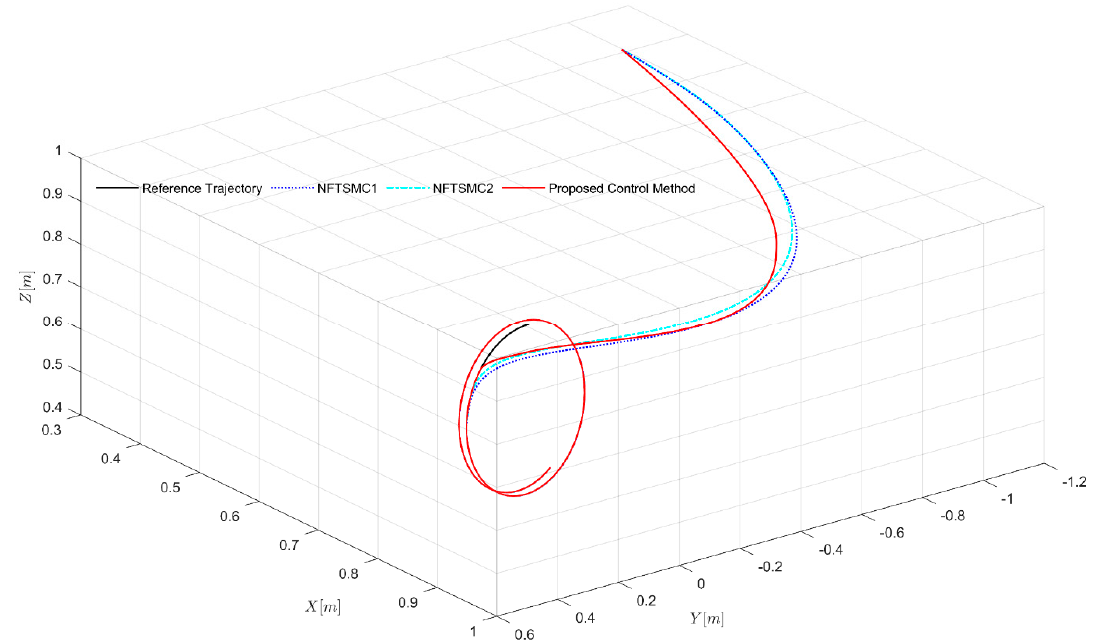
Figure 5. Specified path and actual path of the end effector of the robot under three control strategies in 3-dimensional space (XYZ).